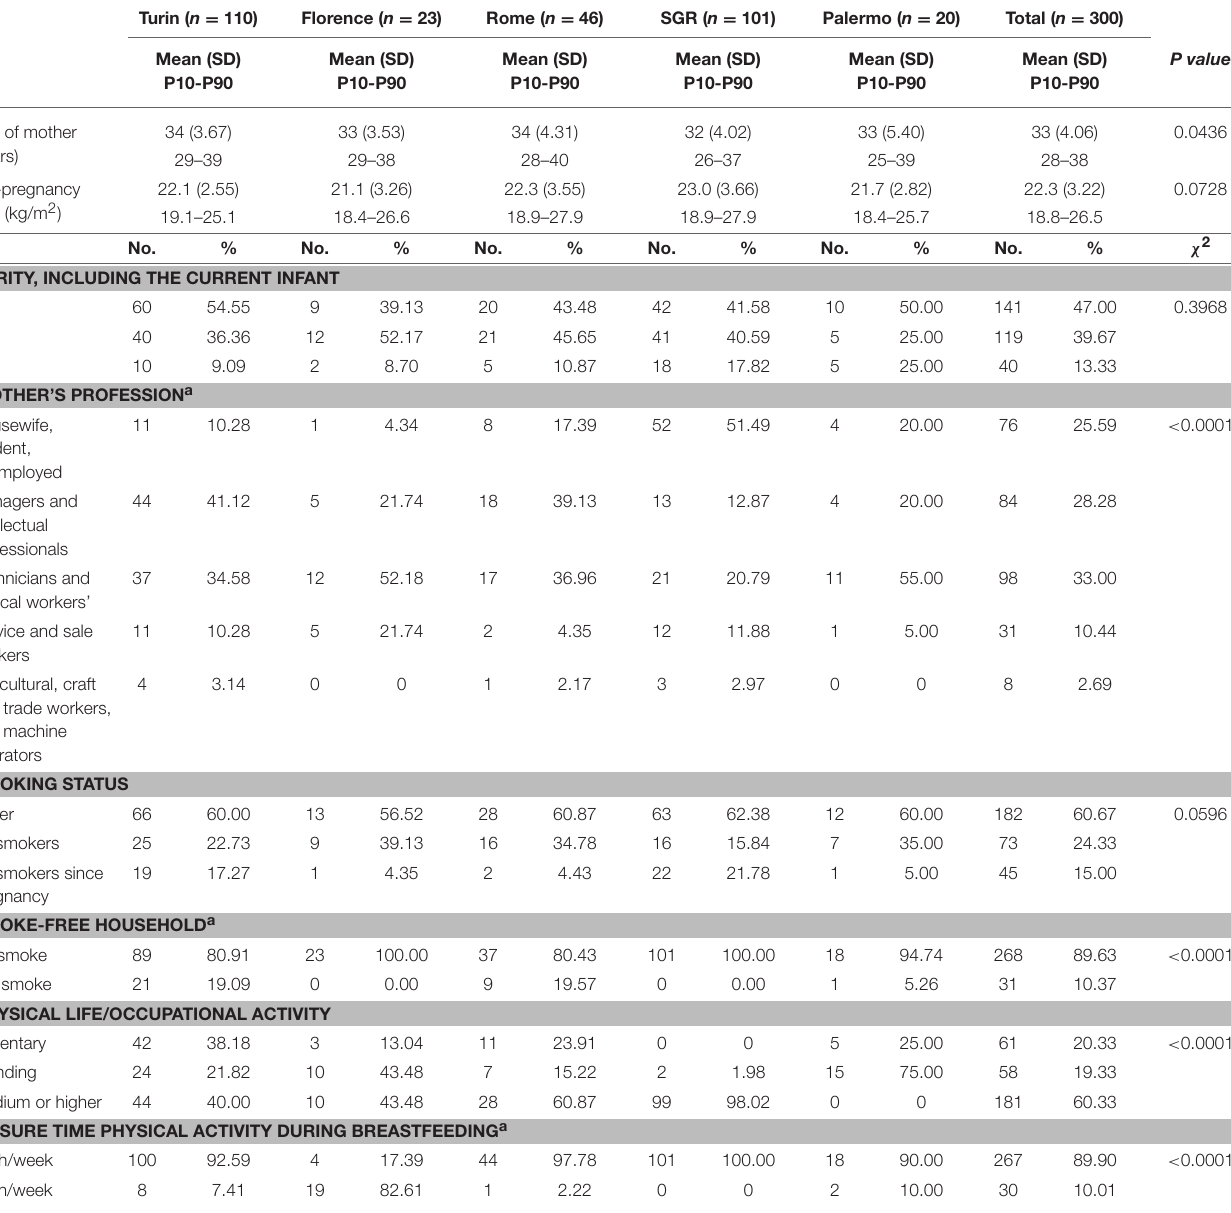
TABLE 2 | Characteristics of 300 mothers by